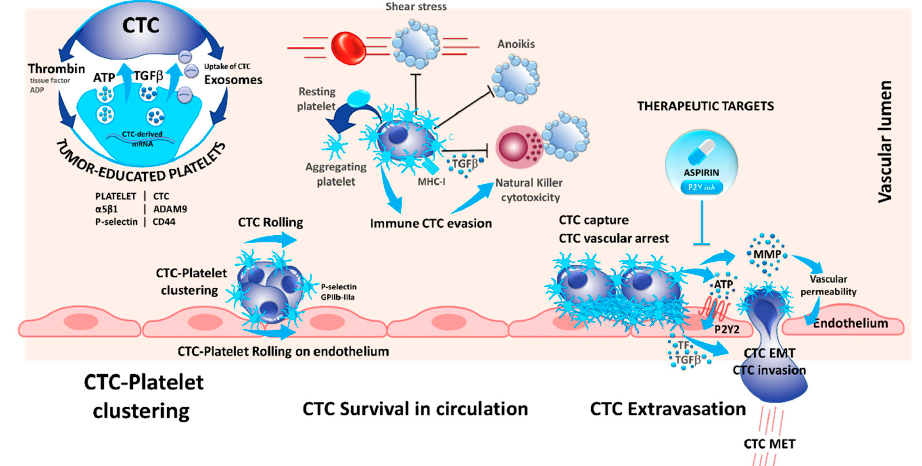
Figure 2. The dialogue between platelets and CTCs is reciprocal: CTCs activate and educate platelets while platelets contribute to CTCs’ survival, escape from immune surveillance, tumor–endothelium interactions, and dissemination. Secretion of α -granules by activated platelets release high levels of TGF- β and ATP, a powerful activator of epithelial-to-mesenchymal transitioned (EMT) state and an endothelium relaxation factor (via P2Y), respectively. Inhibition of platelet α -granules secretion (Cox1) by aspirin, or of P2Y may abolish the metastatic potential of CTCs.